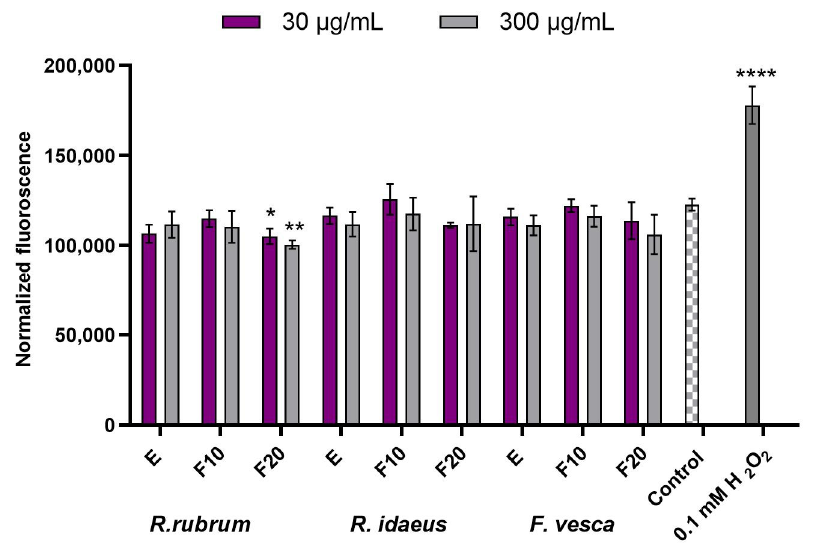
Figure 3. Effect of R. rubrum, R. idaeus , and F. vesca extracts and kombucha ferments (at concentrations of 30 µg/mL and 300 µg/mL) on the DCF fluorescence in keratinocytes (HaCaT). Data are the mean ± SD of three independent experiments.**** p < 0.0001, ** p < 0.01, * p < 0.05 compared to control.